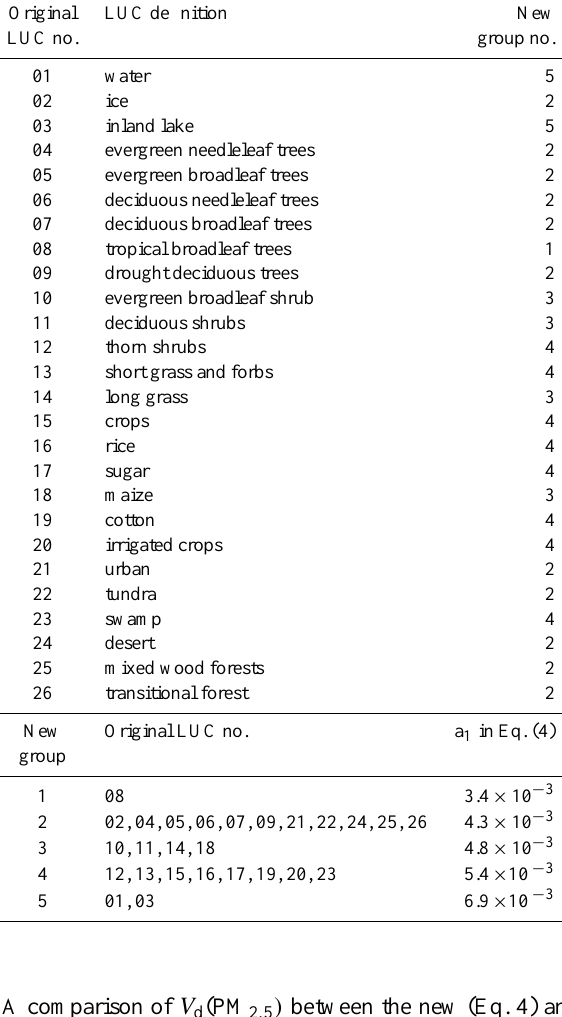
Table 1. The original land use categories (LUCs) and their regroup- ing for the new algorithm for V ds (PM 2 . 5 ) . Empirical constant a 1 for use in Eq. (4) is